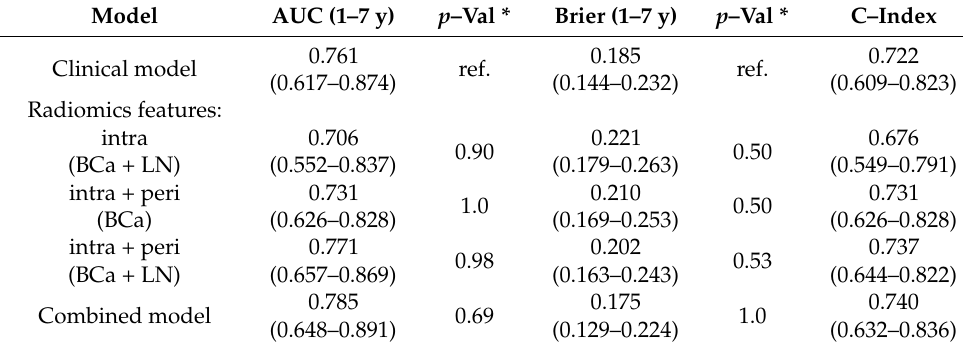
Table 2. Results of the analysis (95% confidence intervals in